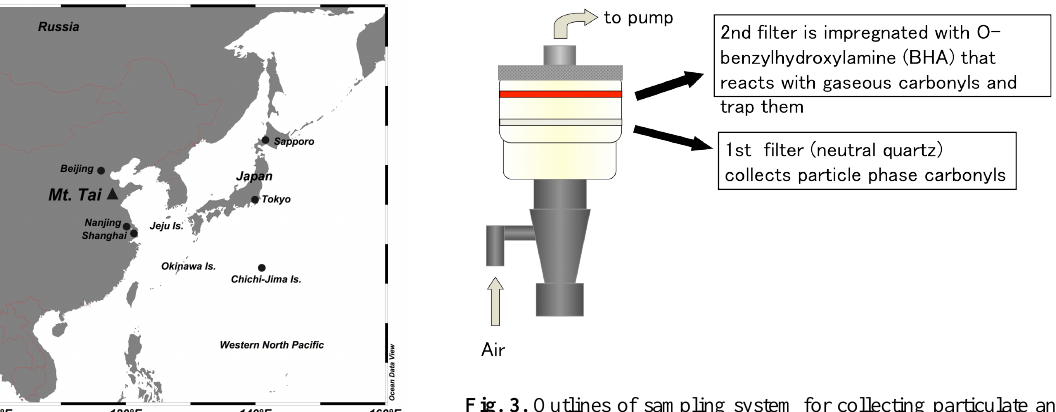
Fig. 3. Outlines of sampling system for collecting particulate and gaseous carbonyls. Table 3. Concentrations (ng m − 3 ) of gaseous and particulate car- bonyls in the air of Mt.